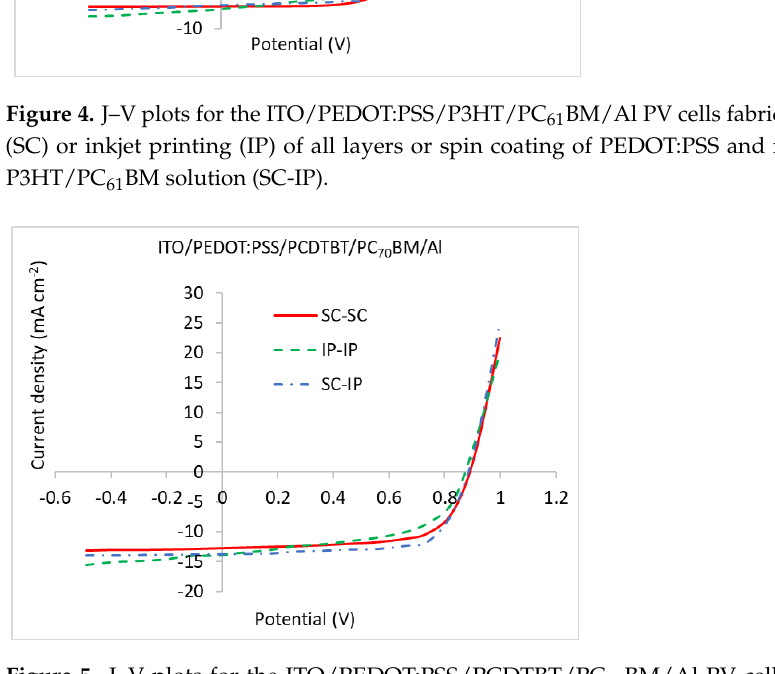
Figure 5. J – V plots for the ITO/PEDOT:PSS/PCDTBT/PC 70 BM/Al PV cells fabricated via spin coating (SC) or inkjet printing (IP) of all layers or spin coating of PEDOT:PSS and inkjet printing of the PCDTBT/PC 70 BM solution (SC-IP). the PCDTBT/PC 70 BM solution